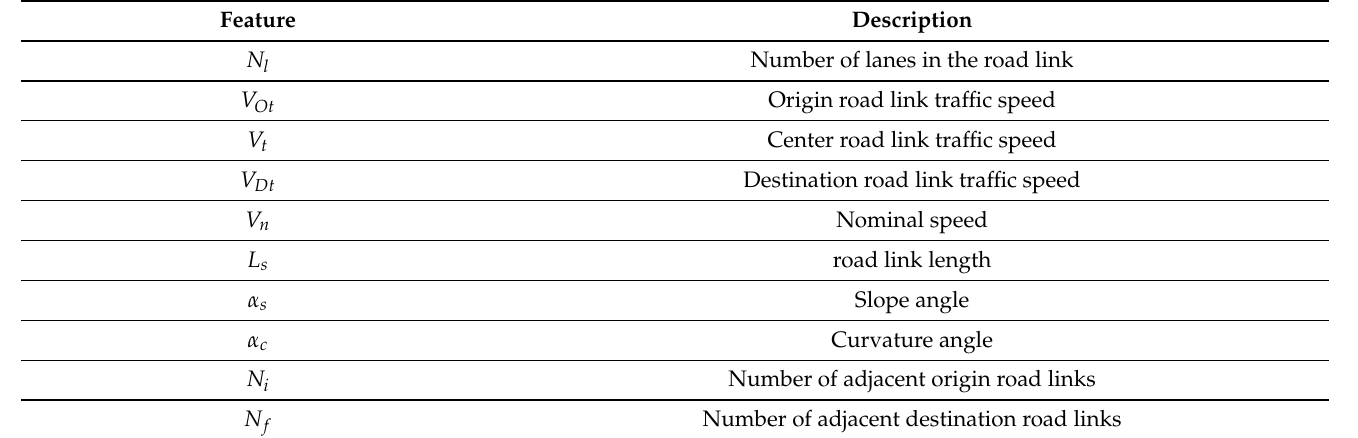
Table 3. Features used as inputs of the RF